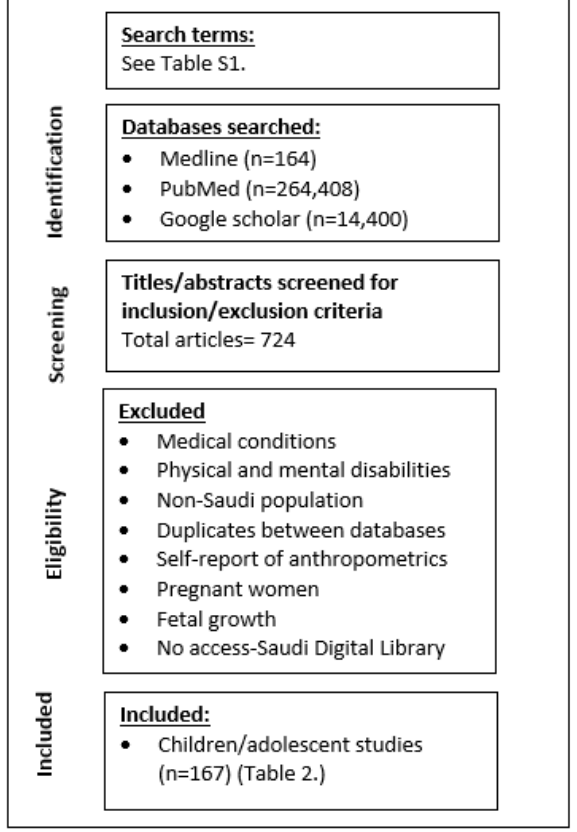
Figure 1. Search results (exclusion/inclusion) and total number of studies